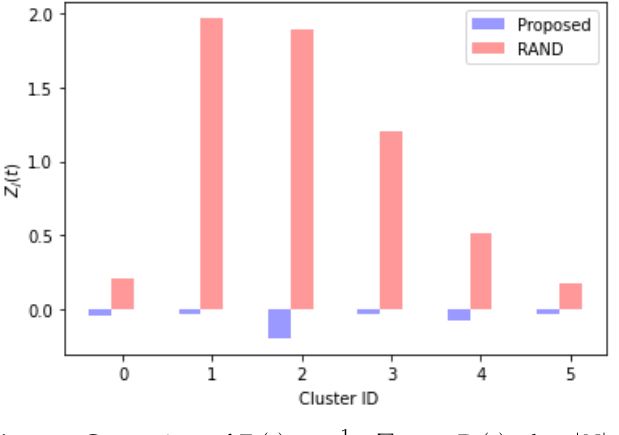
Figure 6. Comparison of Z j ( t )